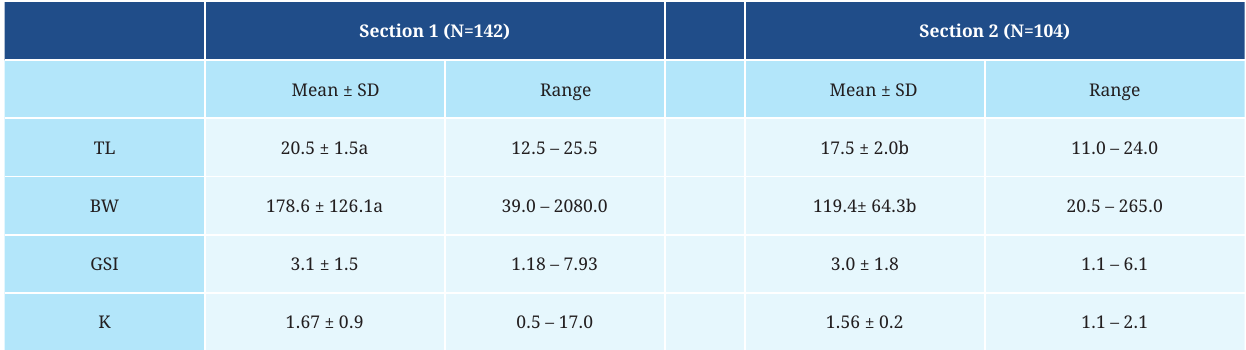
TABLE 2 | Biological parameters of male Leporinus piau captured in two sections of the São Francisco River basin (SFR) from May 2015 to April 2016: section 1 - Três Marias Reservoir (TMR); section 2 - SFR downstream of TMR at the confluence of the SFR with the Abaeté River. N = number of fish caught; TL = total length; BW = body weight; GSI = gonadosomatic index at maturation/mature stage; K = Fulton condition factor.